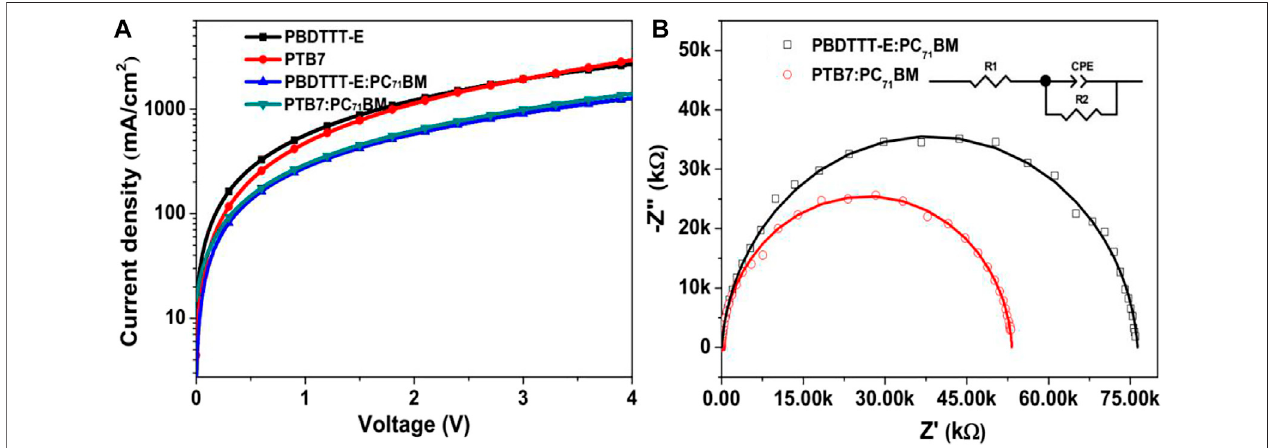
FIGURE9|(A) J – V characteristics ofhole-onlydevicesbasedonthecon fi gurationofITO/MoO 3 /activelayer/MoO 3 /Ag. (B) EISspectraofPBDTTT-E:PC 71 BMand PTB7:PC